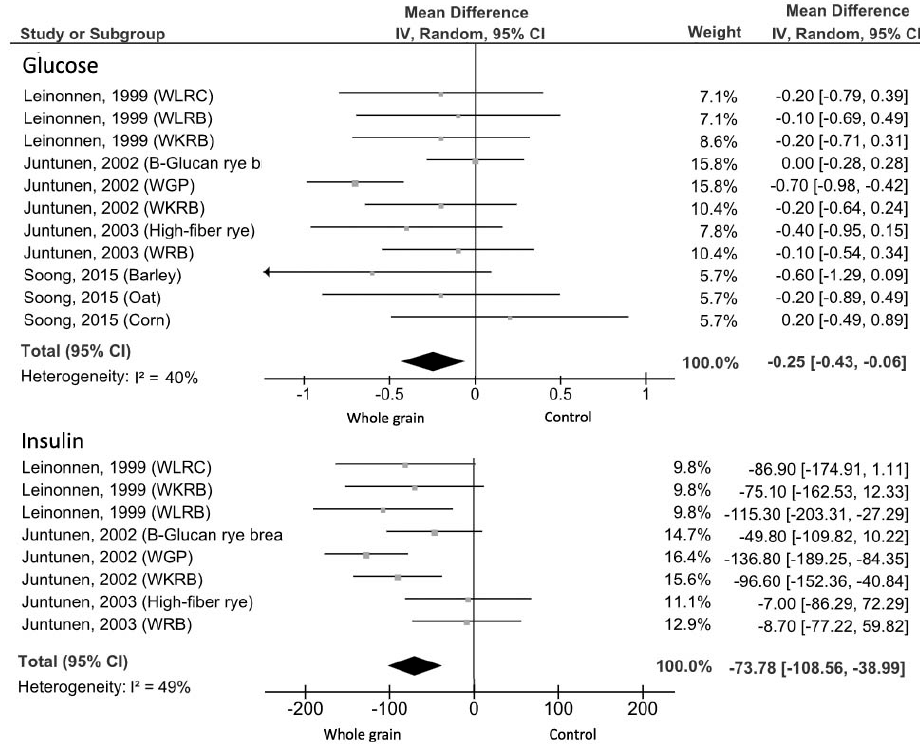
Figure 4. Forest plot of the meta-analysis carried out to investigate the effect of whole grain consumption on maximal glucose and insulin response. WLRC, wholemeal rye crispbread; WLRB, wholemeal rye bread; WKRB, whole kernel rye bread; WGP, whole grain pasta; WKRB, whole kernel rye bread; WRB, Whole rye bread.